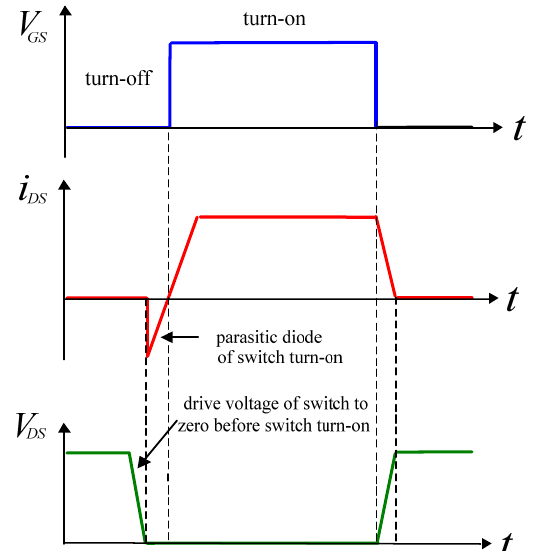
Figure 4. Illustration of ZVS for an active